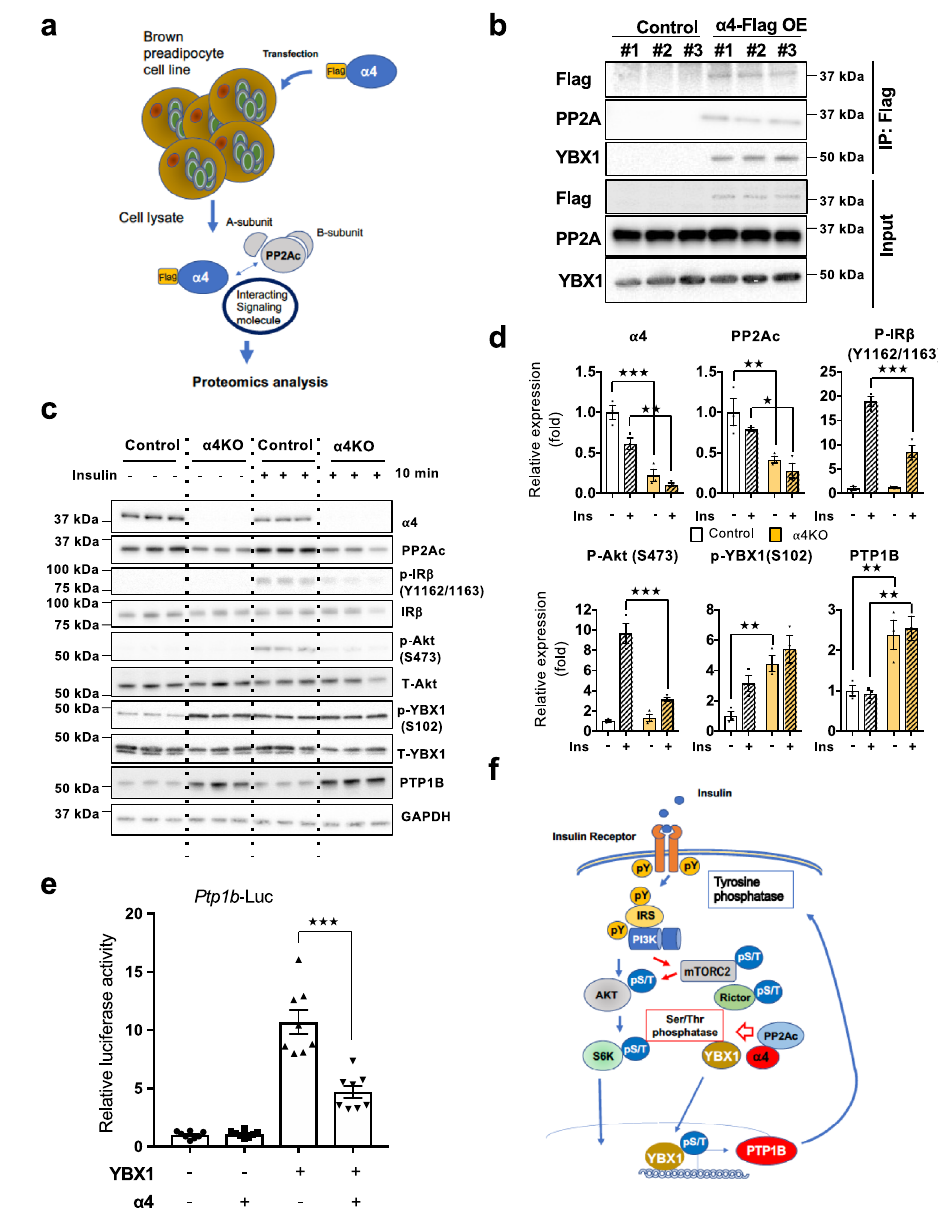
Fig. 2 | α 4 regulates IR Tyr phosphorylation via YBX1 and PTP1B. a